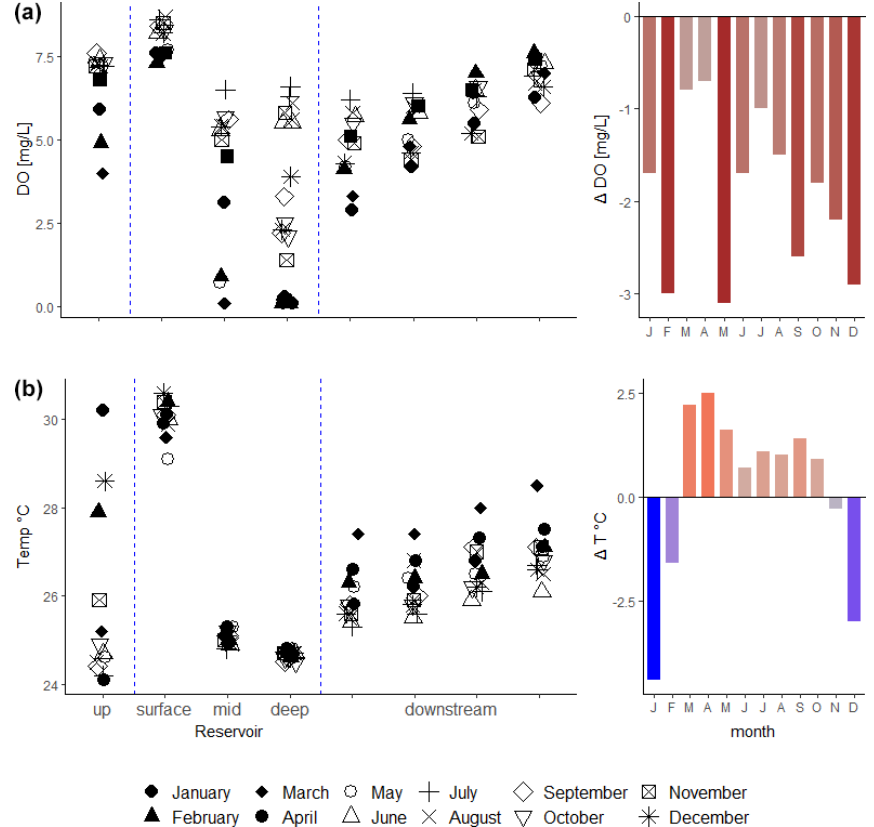
Figure 6. Monthly monitoring data from the Urrá Reservoir in Cordoba, Colombia, in 2018 showing the upstream, reservoir and downstream (a) dissolved oxygen concentration and (b) temperature; the upstream–downstream difference is also shown for the two abovementioned parameters. Data were sourced from Autoridad Nacional de Licencias Ambientales, and data accessibility is described in Sect.